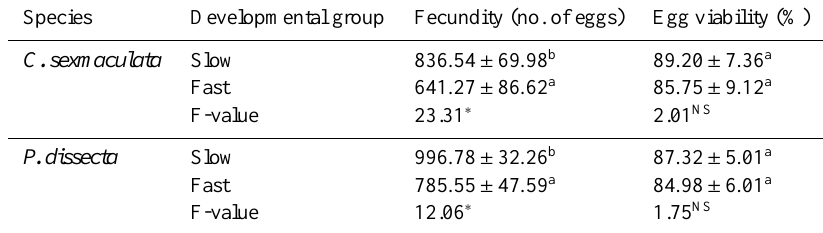
Table 2. Comparison of means of life history attributes of C. sexmaculata and P. dissecta .